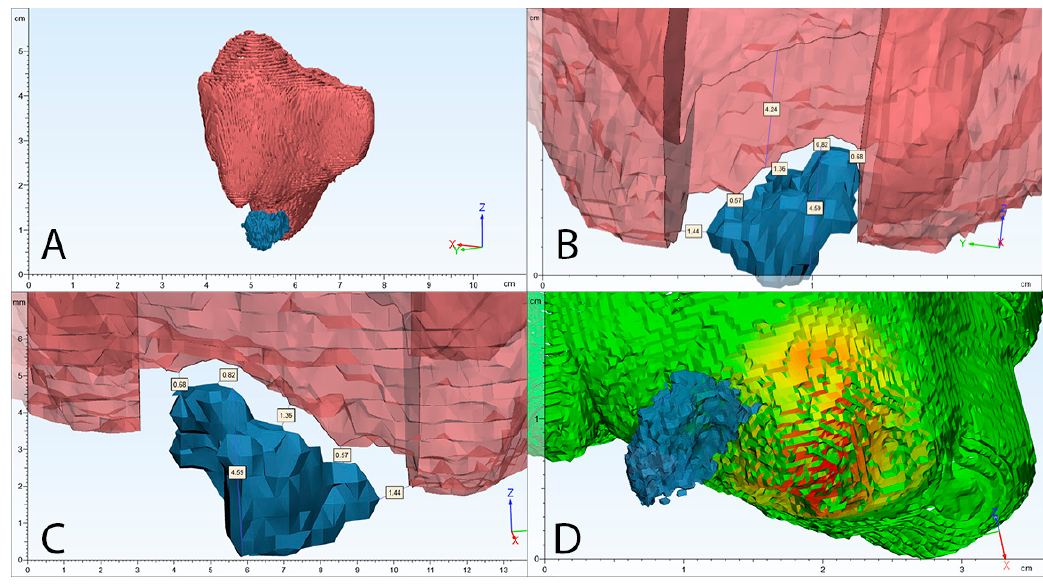
Figure 4. Clinical case volumetric and two-dimensional analysis example. ( A ) segmented 3D view of maxillary sinus mucosa (red) and periapical bone lesion (blue); ( B ) cross-section of maxillary sinus mucosa, maximum thickening area; ( C ) 3D location of periapical bone destruction according to maxillary sinus mucosa with evaluation of highest diameter of periapical bone destruction and shortest distance between these structures; ( D ) automatic algorithm analysis of maxillary sinus mucosa thickening in mm (results are shown in coloured histogram: green—the lowest, red—the highest mucosal thickening).